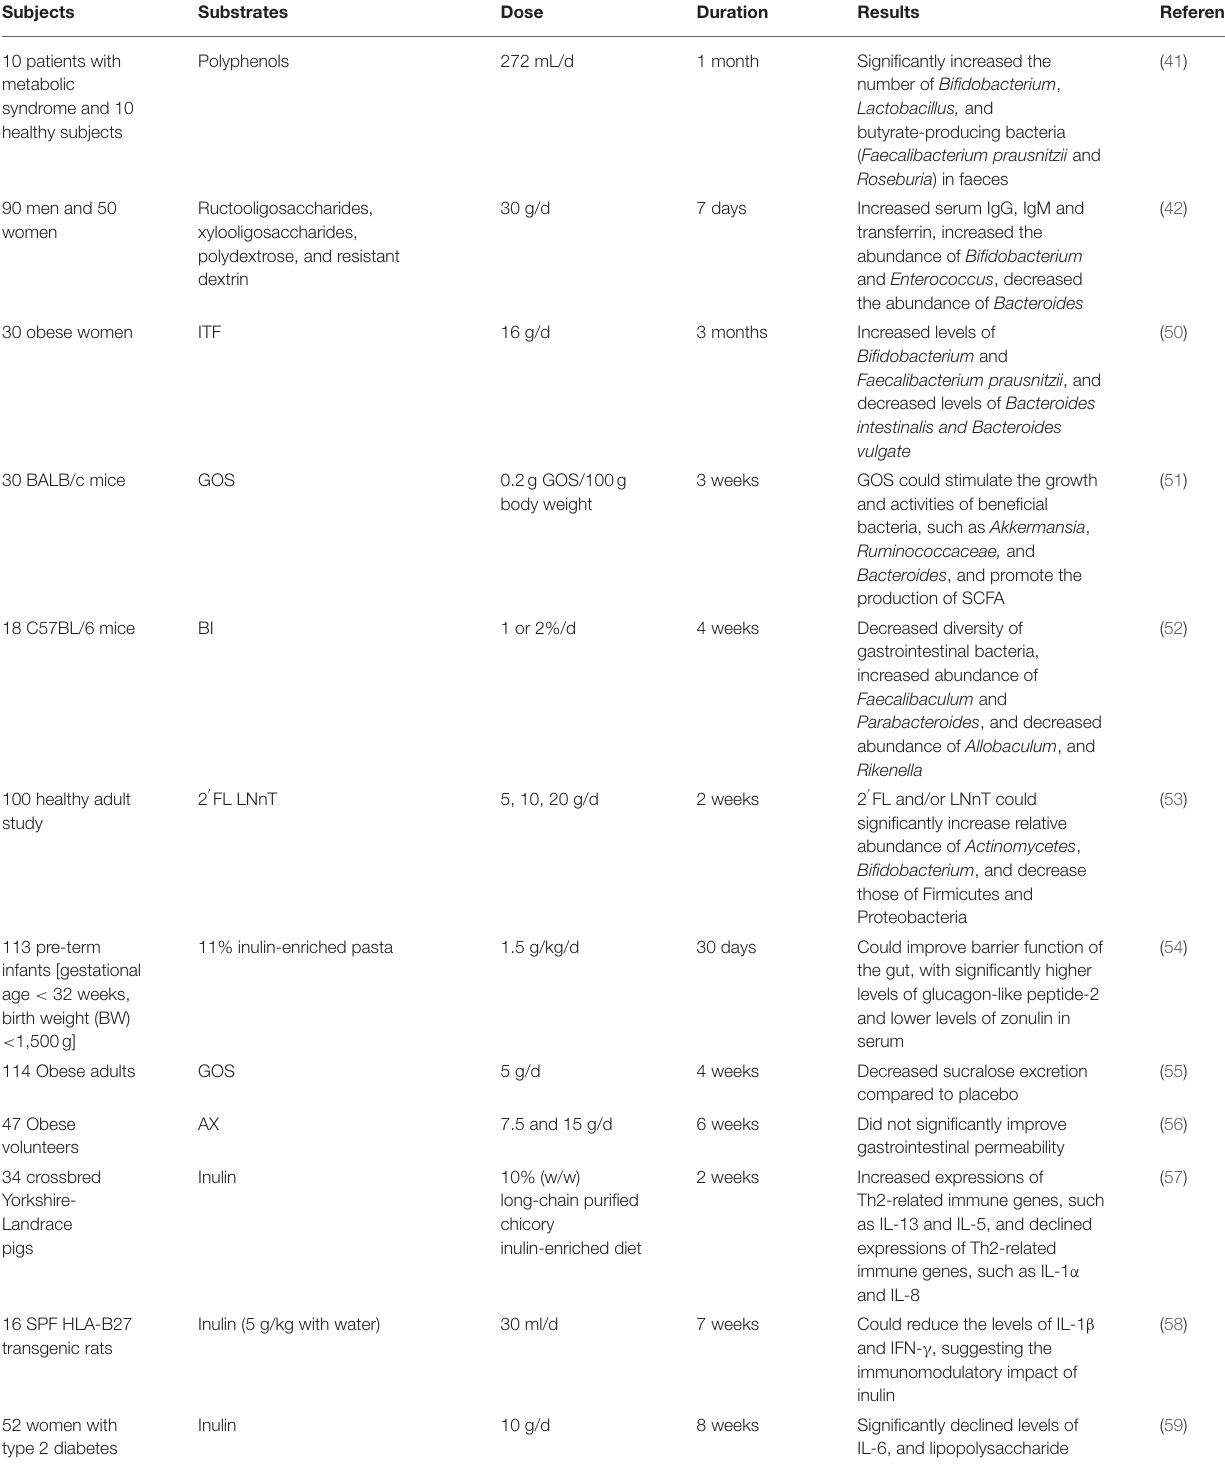
TABLE 2 | Example of studies designed to determine effects of pre-biotics on gut microbiota and immune function.